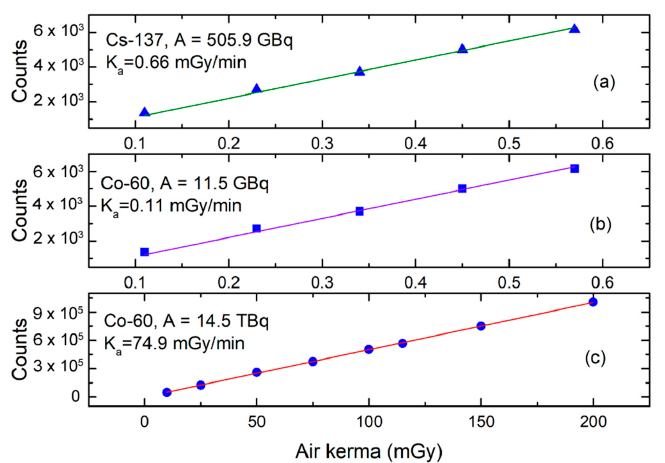
Figure 8. Response of 4H ‐ SiC detector with active surface area of 2 × 2 mm 2 to ( a ) Cs ‐ 137 source with activity of 505.9 GBq and to two Co ‐ 60 sources with activities of 14.5 TBq and 11.5 GBq, ( b ) and ( c ). Linear dose response of the 4H ‐ SiC detector is observed for a stronger and weaker Co ‐ 60 source. However, different curve slopes suggest that the irradiations with lower air kerma rate results with creations of more electron ‐ hole pairs per air kerma than the higher air kerma rate. The same behavior was observed for 4H ‐ SiC detectors with 1 × 1 mm 2 and 3 × 3 mm 2 surface area, but for clarity, only measurements with 2 × 2 mm 2 4H ‐ SiC detector is presented here.